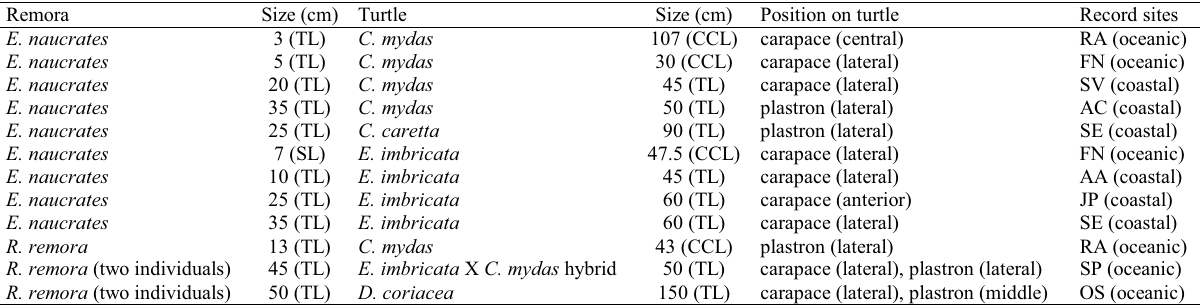
Table 1 . Remoras recorded on marine turtles in Southwest Atlantic (a single remora per turtle unless stated otherwise): fish and turtle sizes, positions on host, and record sites. AA= Abrolhos Archipelago, NE Brazil; AC= Arraial do Cabo, SE Brazil; FN=